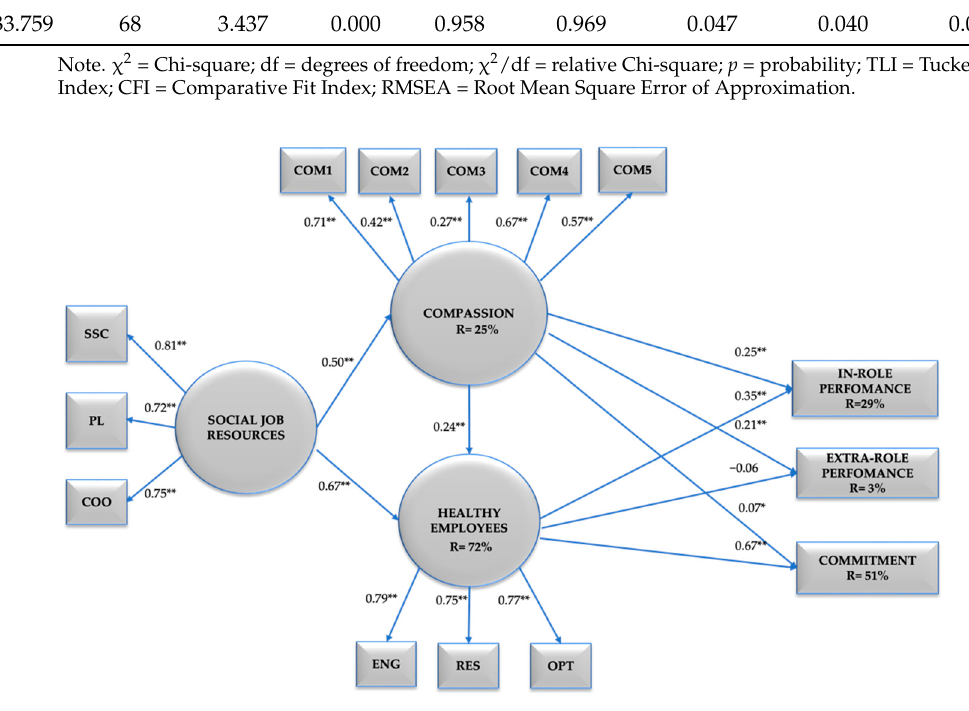
Figure 2. Final model: Structural Model of Compassion, Social Job Resources, Healthy Employees and Healthy Organisational Outcomes in women (N = 1117). Note. SSC = Social Support Climate, PL = Positive Leadership, COO = Coordination, COM1 = Compassion Item 1, COM2 = Compassion Item 2, COM3 = Compassion Item 3, COM4 = Compassion Item 4, COM5 = Compassion Item 5, ENG = Engagement, RES = Resilience, OPT = Optimism. ** p < 0.01, * p < 0.05.